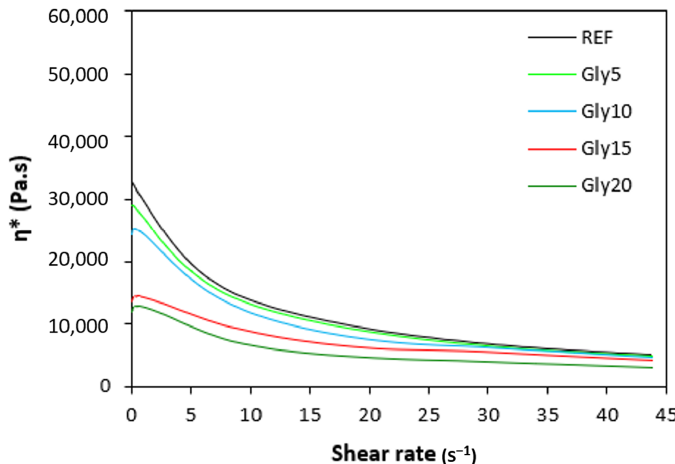
Figure 12. Dependence of dynamic complex viscosities η* of rubber compounds NBR-L30 on shear rate.